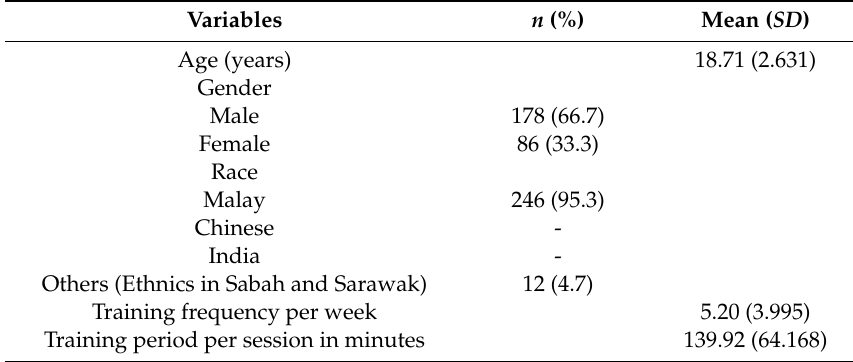
Table 1. Summary of the Silat athletes’ demographic characteristics.